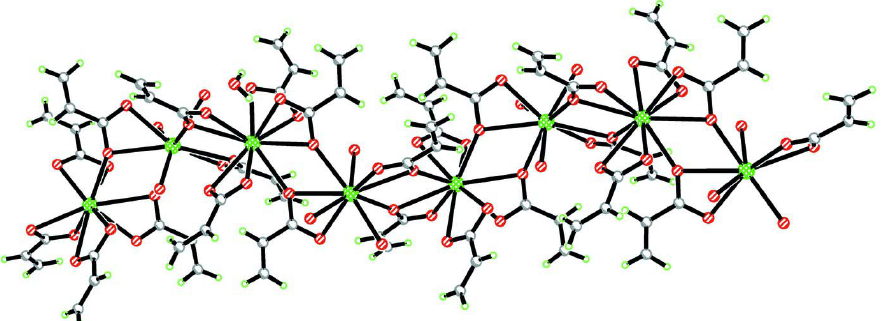
Figure 2 One-dimensional coordination polymers running along the [010]